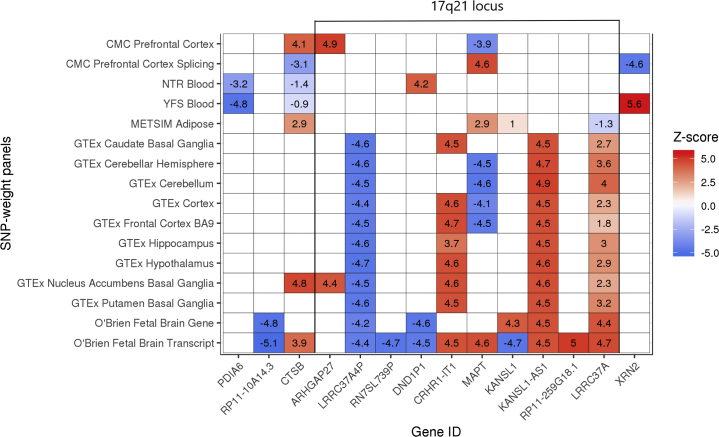
Transcriptome-wide significant genes across single nucleotide polymorphism (SNP) weight sets. Transcriptome-wide significance as a Z score is ∼4.6. The direction of effect for splicing and transcript SNP weights should be interpreted with caution owing to the often inverse relationship between alternative transcripts of the gene (11). Blank squares indicate that the gene weights were not available in the target tissue. BA, Brodmann area; CMC, CommonMind Consortium; GTEx, Genotype-Tissue Expression project; METSIM, Metabolic Syndrome in Men study; NTR, Netherlands Twin Registry; YFS, Young Finns Study.